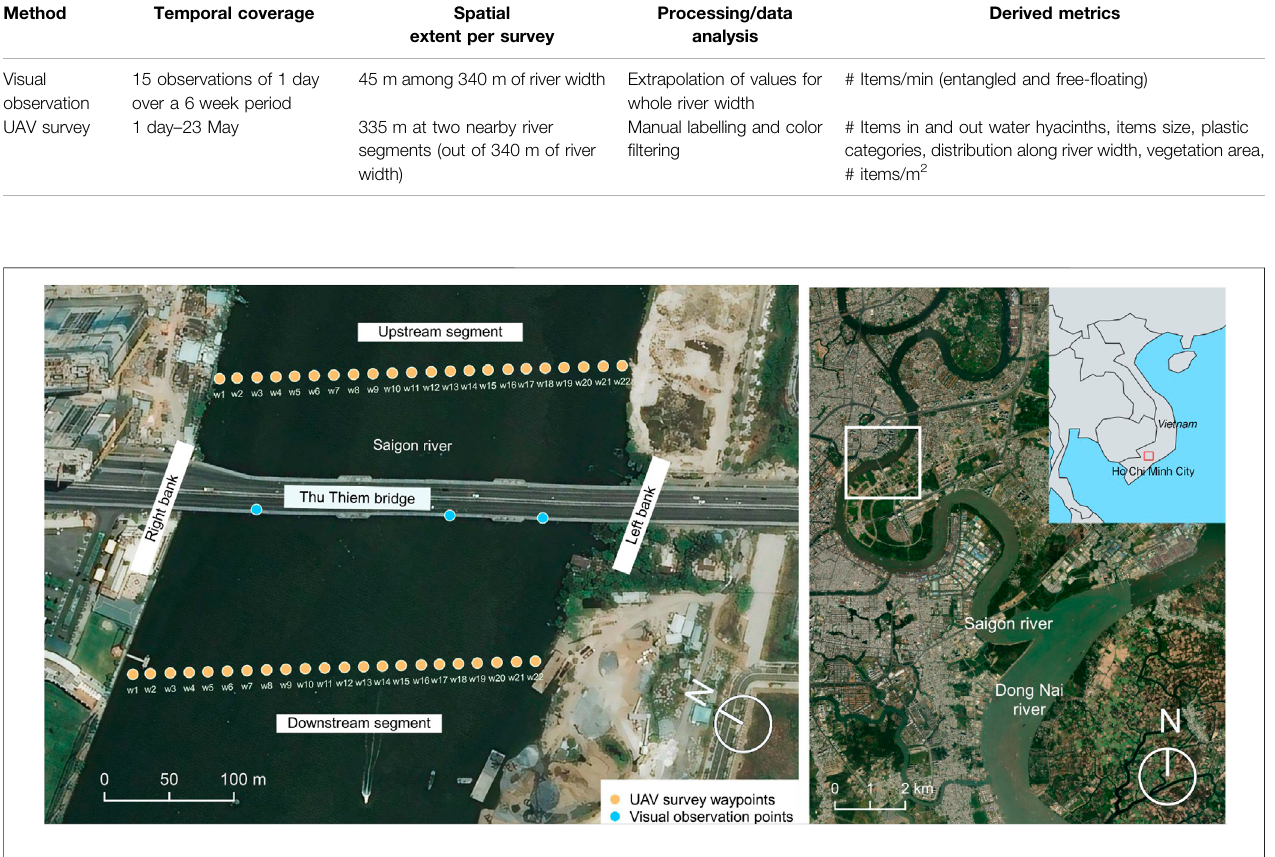
Frontiers in Environmental Science |